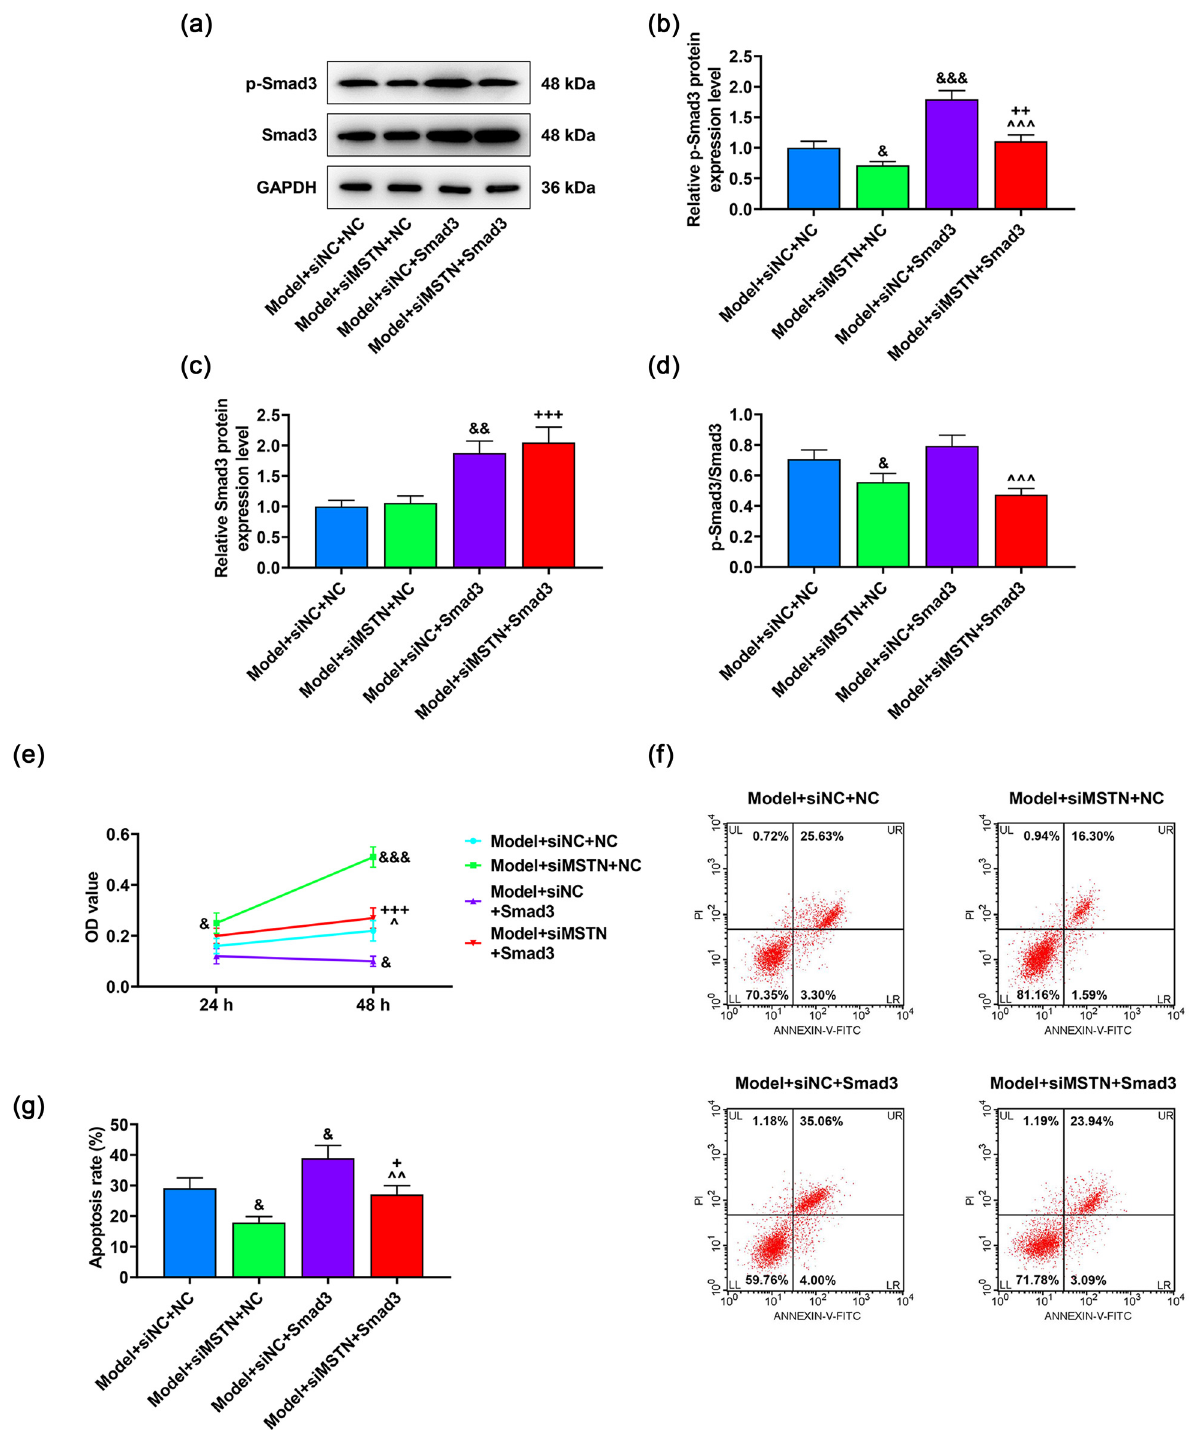
Figure 5: E ff ects of overexpressed Smad3 on the viability and apoptosis of MN model cells. AB8/13 cells were treated with Ang II ( 100nmol/L ) to induce MN cell model, followed by the transfection of siNC or siMSTN and NC or Smad3 overexpression plasmid. ( a – d ) Protein expressions of p - Smad3andSmad3aswellasp - Smad3/Smad3ratioweredetectedbywesternblot.GAPDHfunctionedastheinternalreference. ( e ) CCK - 8assaywas employed to measure the cell viability after the transfection and modeling. ( f and g ) Flow cytometry was applied to test the apoptosis of AB8/13 cells after the transfection and modeling. All experiments were repeated three times to obtain average values. The data are exhibited as the mean ± SD of three independent experiments; & p < 0.05, && p < 0.01, &&& p < 0.001 vs Model + siNC + NC; + p < 0.05; ++ p < 0.01; +++ p < 0.001 vs Model + siMSTN + NC; ^^ p < 0.01, ^^^ p < 0.001 vs Model + siNC + Smad3. Abbreviation: MN, membranous nephropathy; MSTN, myostatin; GAPDH, glyceraldehyde - 3 - phosphate dehydrogenase; CCK - 8, cell counting kit - 8; siMSTN, small interfering RNA targeting MSTN; siNC, siRNA negative